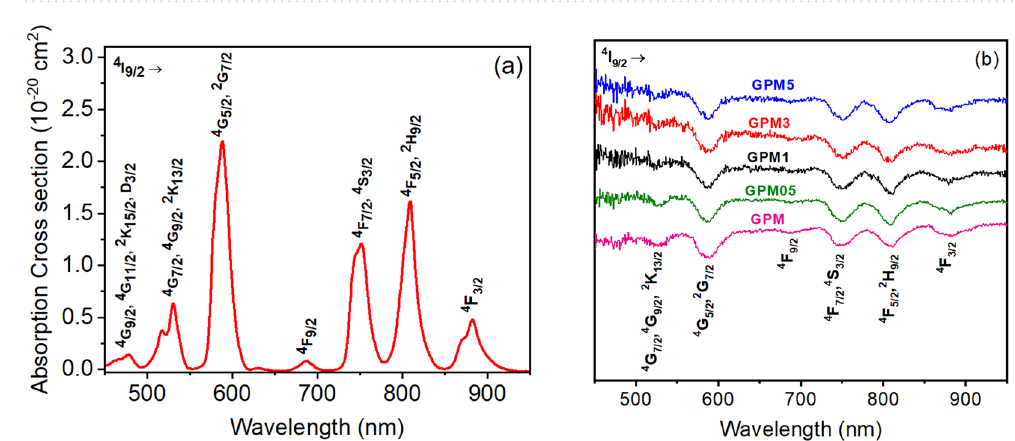
Figure 5. ( a ) Absorption cross section of the precursor GPM glass with neodymium ions. The absorption bands are due to transitions from the ground state to the Nd 3+ excited states. ( b ) Diffuse reflectance spectra of all prepared powders. The spectra are shifted in the vertical axis to prevent